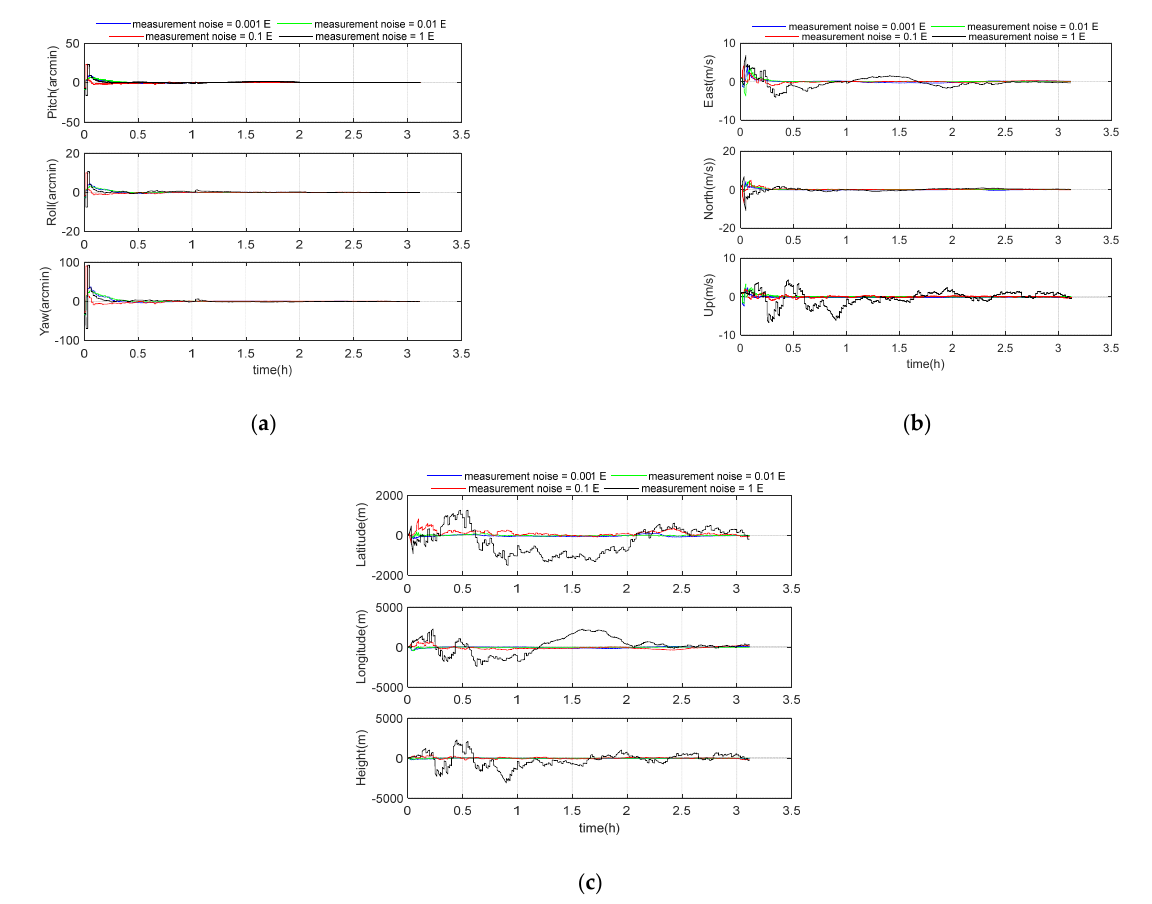
Figure 5. ( a ) Attitude error curve; ( b ) velocity error curve; ( c ) position error curve. Table 4. Simulation results under different measurement noise.